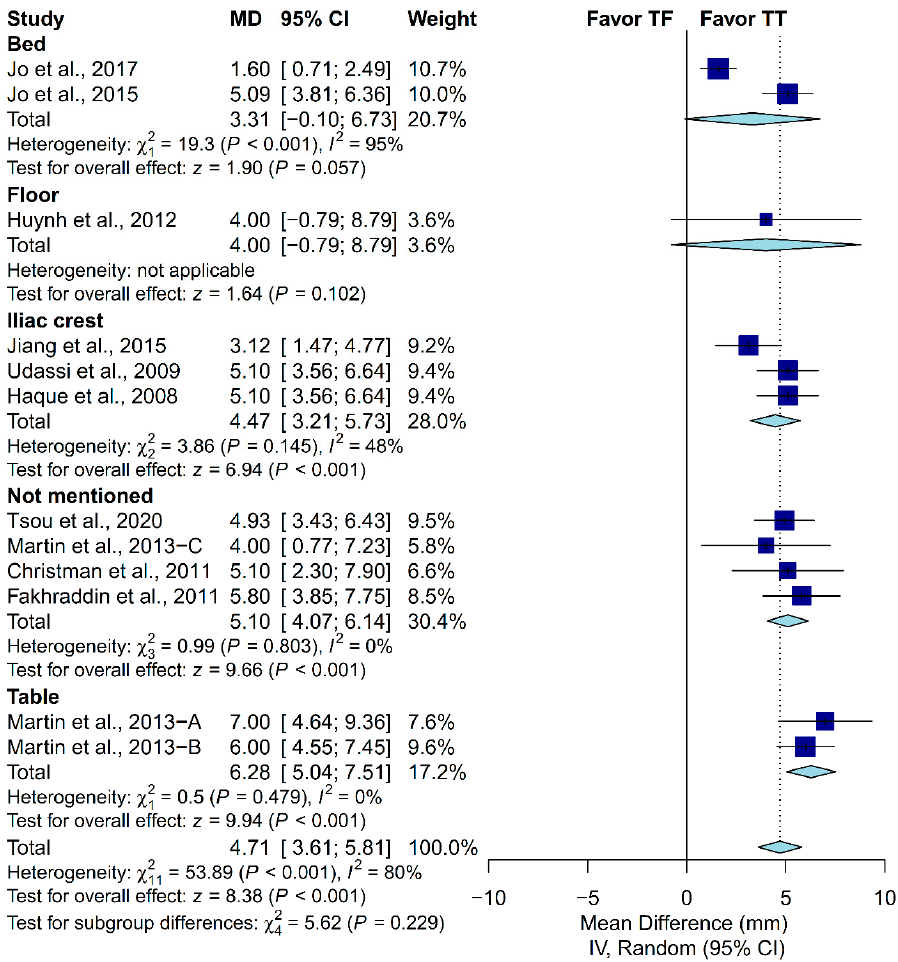
Figure 7. Subgroup analysis of chest-compression depth grouped by manikin placement.